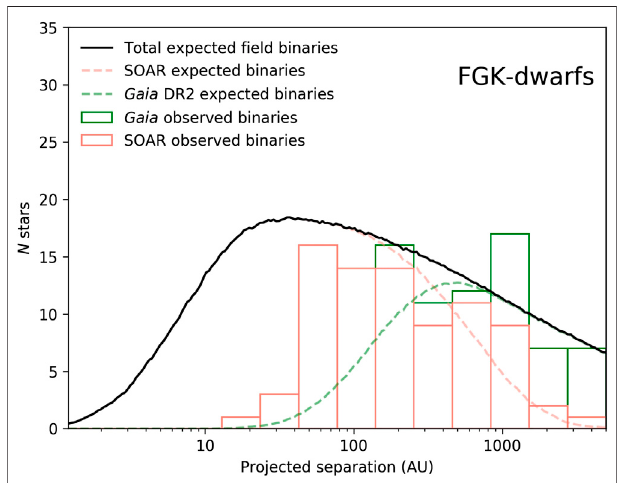
FIGURE5| In red and green, thenumber ofobserved companions from SOAR and in Gaia DR2 for solar-type TESS planet candidate hosts in logarithmicbinsofprojectedseparationof0.25 dexwidth.Companionsfound bybothSOARand Gaiaareincluded intheSOARsample.Inblackisthe expected distribution from a multiplicity study of fi eld stars (Raghavan et al., 2010), combining both fi eld binaries that would be detected by SOAR and Gaia. The expected binaries from SOAR and Gaia, individually, are also plotted. These distributions take into account the detection sensitivity of both SOAR and Gaia. The observed distribution shows a clear paucity of TESS planet candidate host binaries at projected separations less than ∼ 40 AU compared to the fi eld stars and are consistent with fi eld expectations at wider